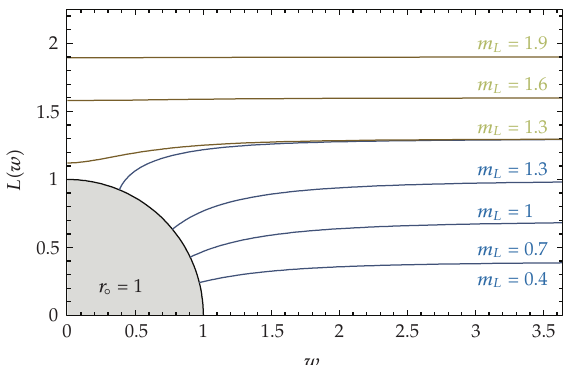
Figure 4: Solutions to (cid:2) 2.70 (cid:3) yield Black hole (cid:2) blue lines (cid:3) and Minkowski embeddings (cid:2) brown lines (cid:3) of D7- branes in the AdS 5 × S 5 black hole background. The jump between black hole and Minkowski embedding at m L (cid:5) 1 . 3 induces a change of the worldvolume topology, reflected in a first-order phase transition of the dual field theory, see (cid:8) 32, 33 (cid:9)